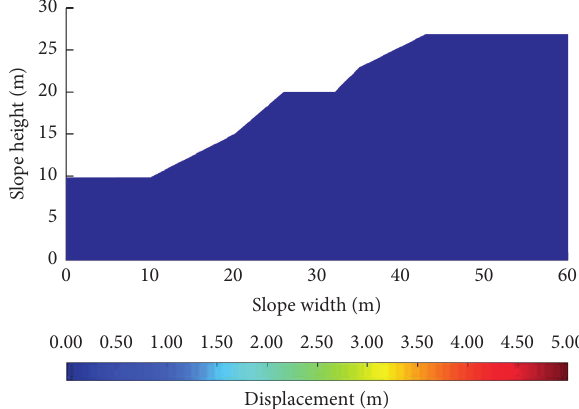
Figure 6: Contour plot of deformation for slope particles at steady